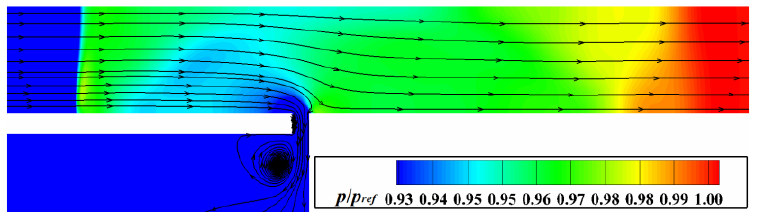
Figure 15. Streamlines and pressure distribution at 0.04 ms for the case of gap width of 0.8 mm, pressure ratio of 1.5.